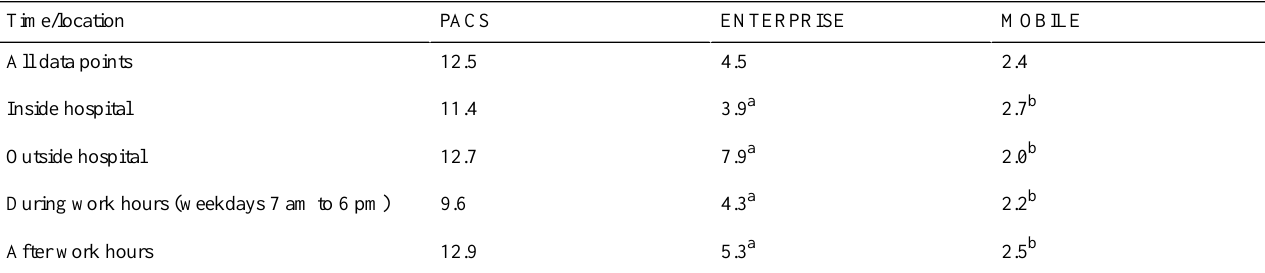
Table 2. Time to first image in minutes by type of image viewer.